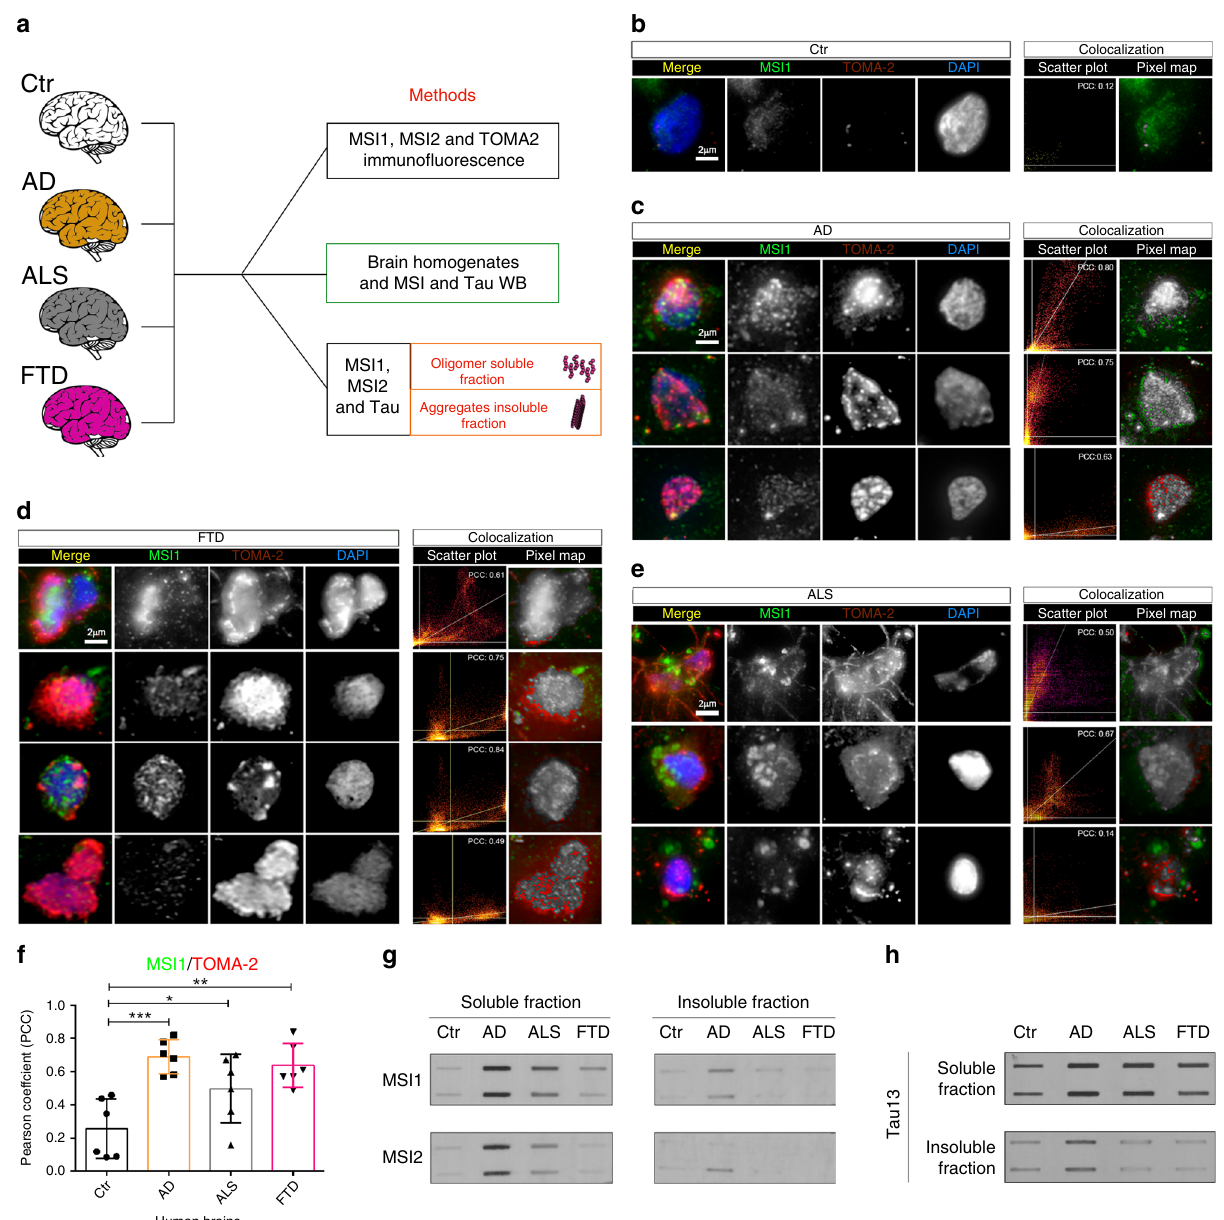
Fig. 2 Intra-subject variability of Musashi deposition in AD, ALS, and FTD frontal cortex. a Schematic approach to study MSI1, MSI2 and Tau deposition in human diseased brains. b Representative confocal image of nuclei stained with MSI1, TOMA-2 and DAPI in control (Ctr) brains. c Confocal images of cortical AD brain showed nuclei stained with MSI1, TOMA-2, and DAPI, three different nuclei are represented for each fi eld the pixel distribution graph and colocalization pixel map has been reported. d Confocal images of cortical FTD brain showed nuclei stained with MSI1, TOMA-2 and DAPI, three different nuclei are represented for each fi eld the pixel distribution graph and colocalization pixel map has been reported. e Confocal images of cortical ALS brain showed nuclei stained with MSI1, TOMA-2 and DAPI, three different nuclei are represented for each fi eld the pixel distribution graph and colocalization pixel map has been reported. In all images merge is presented with MSI1 (green), TOMA-2 (red) and DAPI (blue) white scale bar: 2 µ m. f PCC comparison between MSI1 and TOMA-2 intensities, signi fi cant co-localization has been observed between control and diseased brains. In particular, Ctr vs. AD ***, Ctr vs. ALS *, Ctr vs FTD **, Dunnett ’ s multiple comparisons test One-way ANOVA has been performed with a p -value = 0.0006 between columns. N = 3 biologically independent cells (ROIs) examined over three independent experiments. Data are presented as mean ± SD. g MSI1 and MSI2 soluble and insoluble fraction from Ctr, AD, ALS, and FTD human brains, presented in duplicate. h Tau soluble and insoluble fractions from Ctr, AD, ALS, FTD human brains, presented in MSI1 accumulates in the nuclei and axons of aged P301L mice . slides from C57BL/6, Tau KO and Tau P301L models. We The distribution of MSI protein in different mouse models particularly focused our attention on the P301L model, because (C57BL/6, Tau KO and P301L) was studied over time to our previous cell data showed an abnormal accumulation of determine whether or not the MSI distribution was associated MSI proteins in the presence of higher levels of tau 5 . In 2- month-old animals, nuclear MSI1 localization in the dentate with aging. In particular, we stained for MSI1 and MSI2 brain